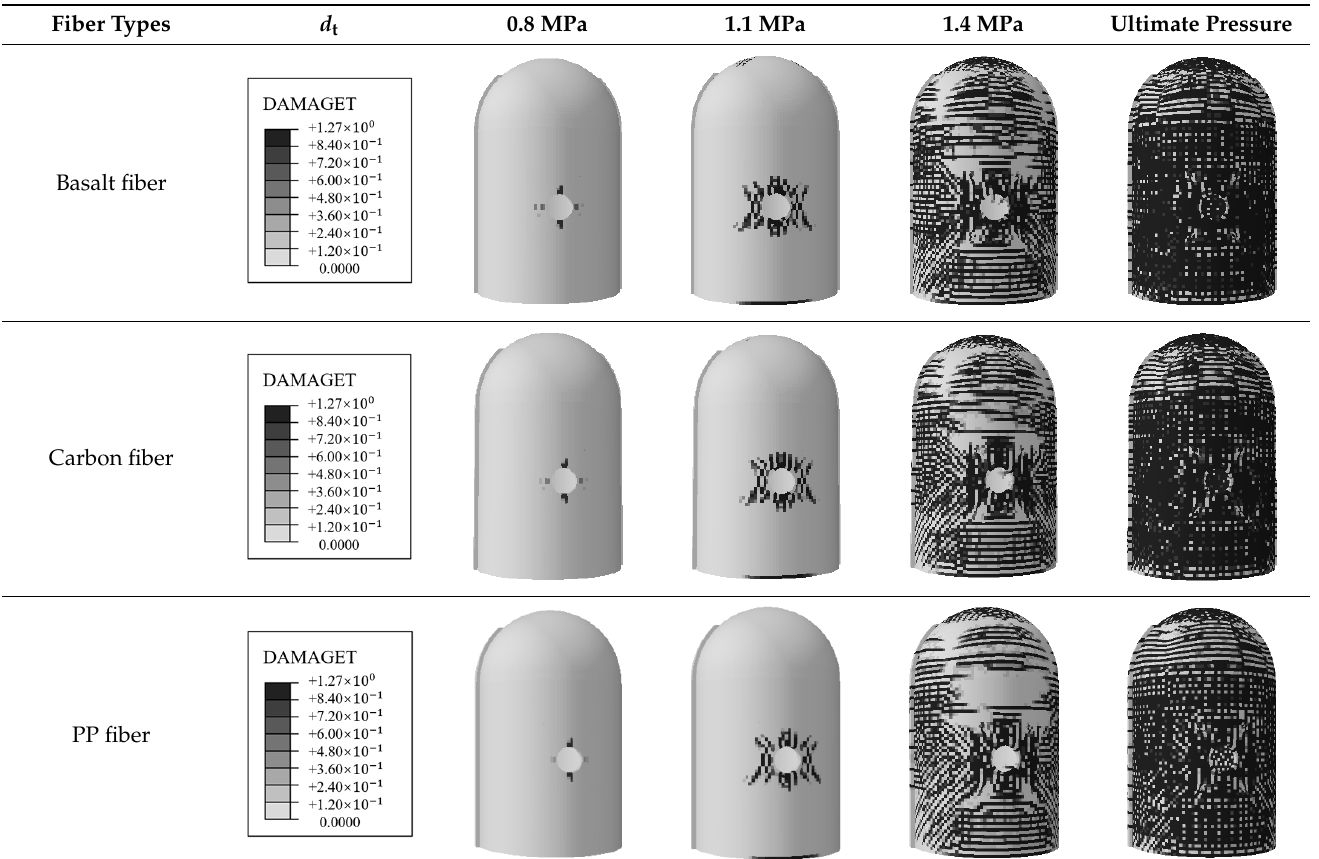
Figure 17. The maximum value of principal tensile strain of different concretes. Table 6. The crack evolution of concrete between the FRC containments.